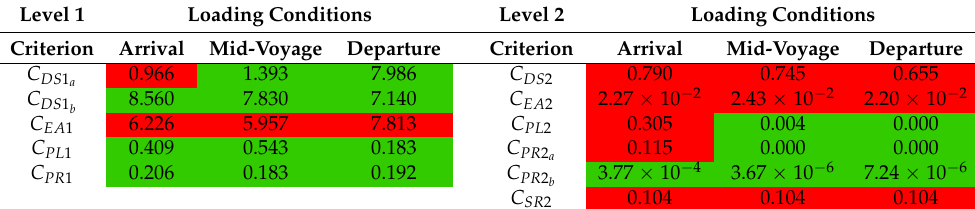
Table 3. Comprehensive assessment of SGISc vulnerability levels for Y01. Criteria compliant with the standard are highlighted in green. Criteria not compliant with the standard are highlighted in